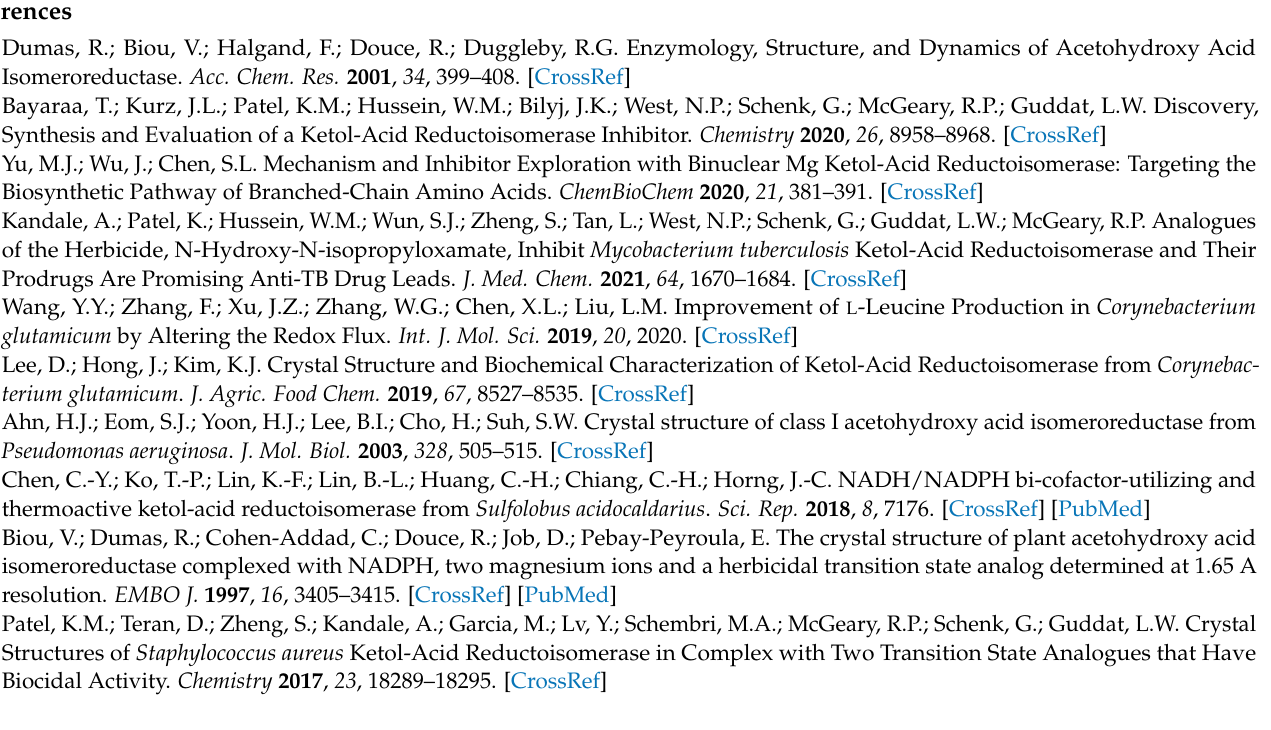
(6KPJ); Figure S9: Evolutionary relationships of the characterised KARIs used in this work; Table S1: Structural alignment of the Mt KARI open and close states to the structurally characterised non- mutant KARIs; Table S2: Structural alignment of the structure of KARIs from C. glutamicum and S. pneumoniae to the structurally characterised non-mutant KARIs; Table S3: Oligomeric state of KARI; Table S4: Oligomeric state of KARIs depending on optimal growing conditions of the organisms. Author Contributions: Protein extraction and purification was performed by T.W. and M.-C.M. Phylogenetic analyses, electrophoreses and size exclusion chromatography were performed by O.N.L. Crystallisation, X-ray data collection, processing was performed by T.W. Model building, refinement and structural analyses were performed by O.N.L. and T.W. Mass spectrometry identification was done by J.K. The data were interpreted and the paper was written by O.N.L. and T.W. with the contributions and final approval of all co-authors. All authors have read and agreed to the published version of the